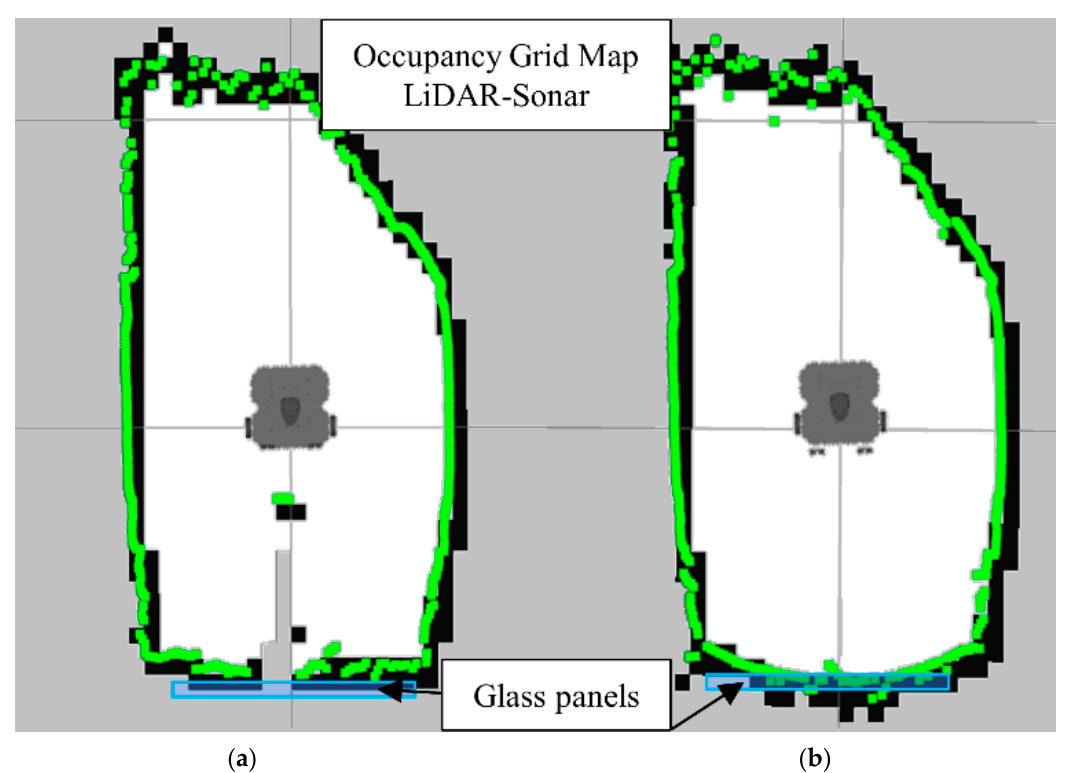
Figure 14. Occupancy grid maps showing the: ( a ) Ground truth (reference map); ( b ) LiDAR-Sonar fusion generated map.